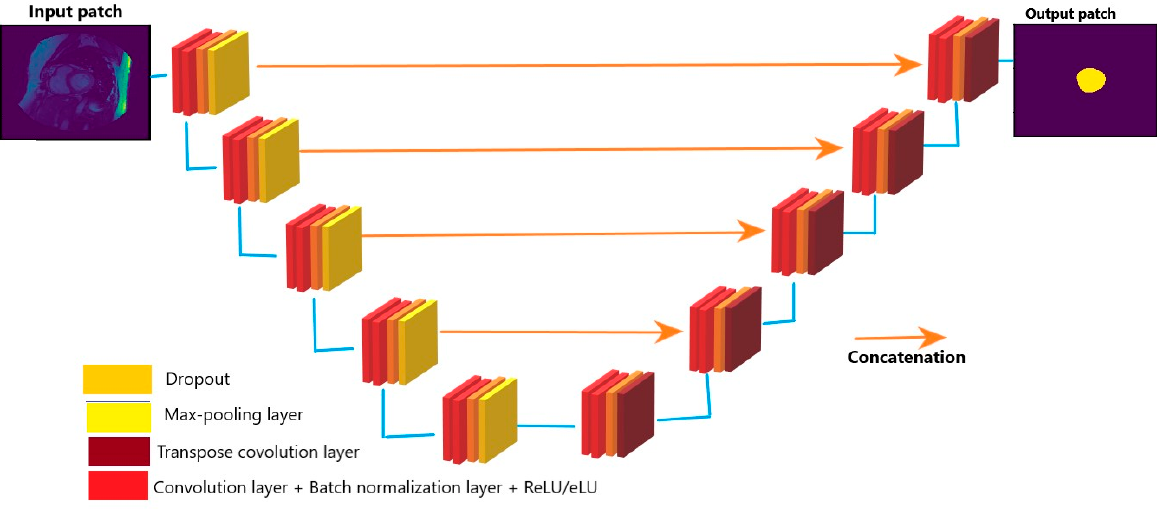
Figure 4. Proposed U-Net architecture.